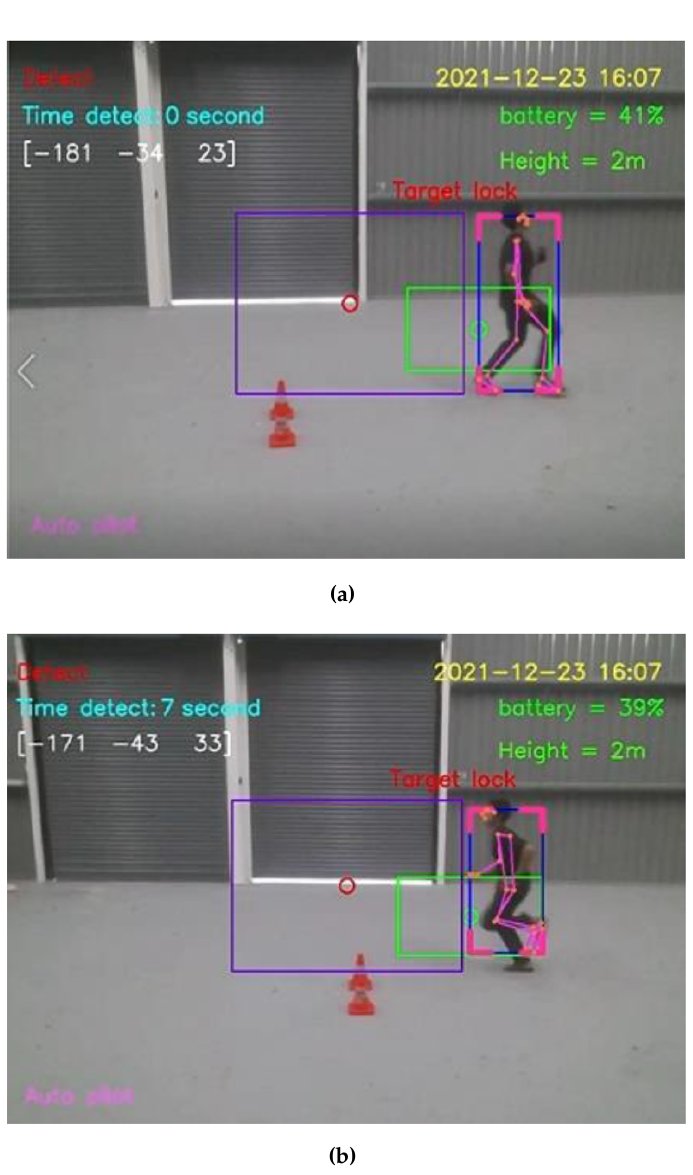
Figure 18. Moving through the Tello EDU drone’s camera: ( a ) Running from left to right to through the Tello EDU drone’s camera ( b ) Running from right to left through the Tello EDU drone’s camera. As shown in Figure 19, visibility significantly decreased as human speed increased. The dotted line represents the polynomial trend-line of visibility, indicating the ability to track human motion gestures at different distances. In the trend line, visibility decreases by 10%, from 100% to 90%, when human motion speed increased from 0.67 to 1.38 m/s; mean- while, visibility decreased 30%, from 90% to 60%, when human motion speed increased from 1.38 to 2.12 m/s. In each movement gesture speed, zigzag walking speed between 0.6536 and 0.6711 m/s provided visibility of 99% on average. At straight walking speed between 0.7716 and 0.7776 m/s, the Tello EDU drone had visibility of 99% on average. When going from left to right (and vice versa) through the Tello EDU drone’s camera at straight walking speed between 1.1834 and 1.2019 m/s, the Tello EDU drone had visibility of 97.5% on